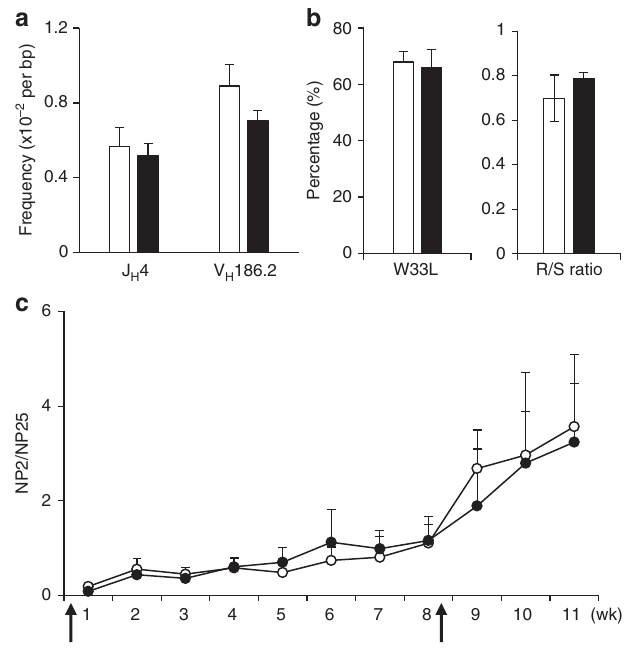
Figure 6 | Normal Ab affinity maturation in Eaf2 (cid:3) / (cid:3) mice. ( a ) Mutation frequency in the J H 4 intronic region and in the V H 186.2 gene in GC B cells isolated from the spleen of WTand Eaf2 (cid:3) / (cid:3) mice immunized with NP–CGG. For the J H 4 intronic region, 251 and 236 unique clones collected from 3 WT and 2 Eaf2 (cid:3) / (cid:3) mice, respectively, were analysed. For the V H 186.2 gene, 177 WT and 117 Eaf2 (cid:3) / (cid:3) unique sequences form 2 WT and 2 Eaf2 (cid:3) / (cid:3) mice were analysed. ( b ) Left, frequency of the tryptophan to leucine substitution at position 33 (W33L). Right, ratio of aa replacement to silent mutations (R/S ratio) in CDR and FWR. Open bar, WT; Solid bar, Eaf2 (cid:3) / (cid:3) mice. ( c ) Ratio of NP2- and NP25-binding Ab titres in WT (open circles) and Eaf2 (cid:3) / (cid:3) (solid circles) mice, calculated from the data shown in Fig. 5a. The arrows indicate immunization time.